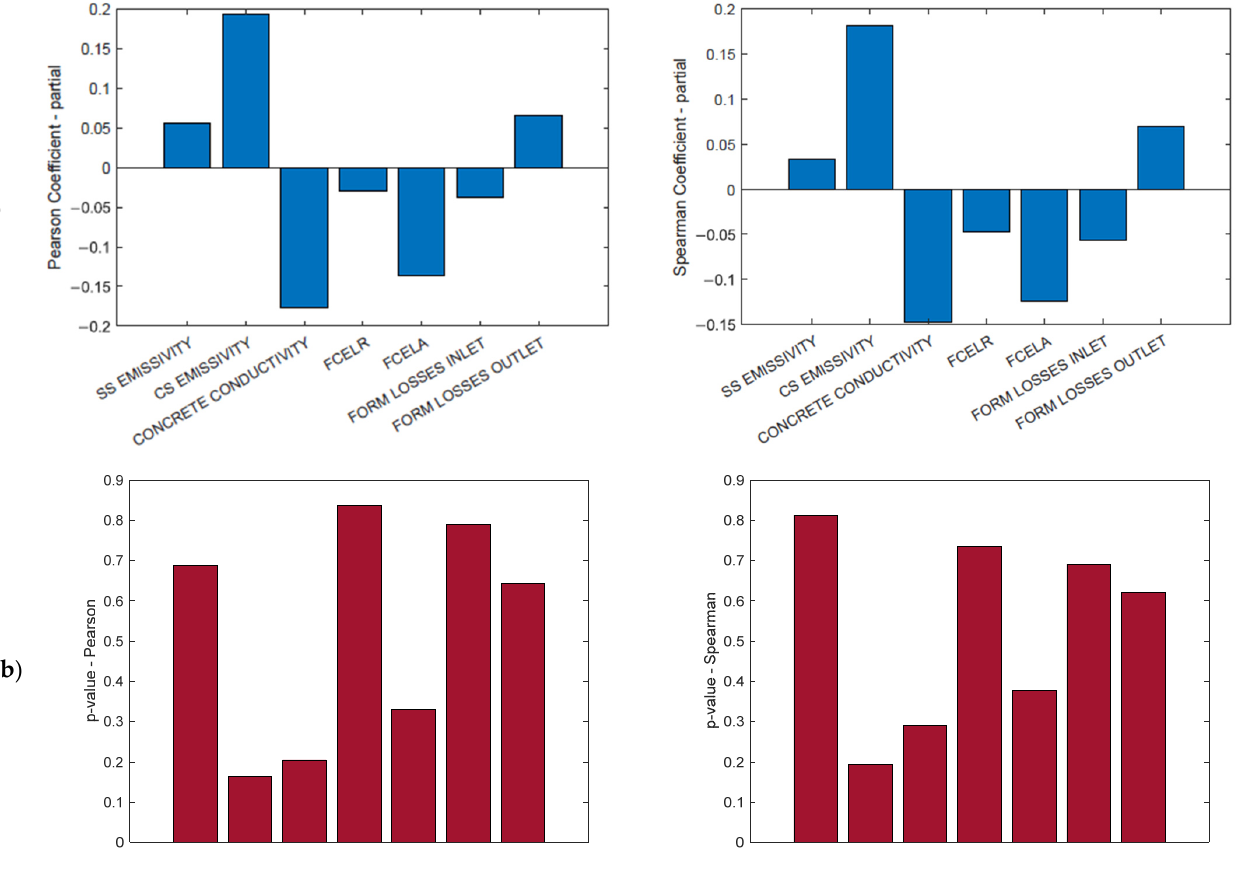
Figure 8. ( a ) The partial Pearson Coefficient ( left ) and partial Spearman Coefficient ( right ); ( b ) the p -values for the Pearson coefficient ( left ) and the p -values for the Spearman coefficient ( right ).